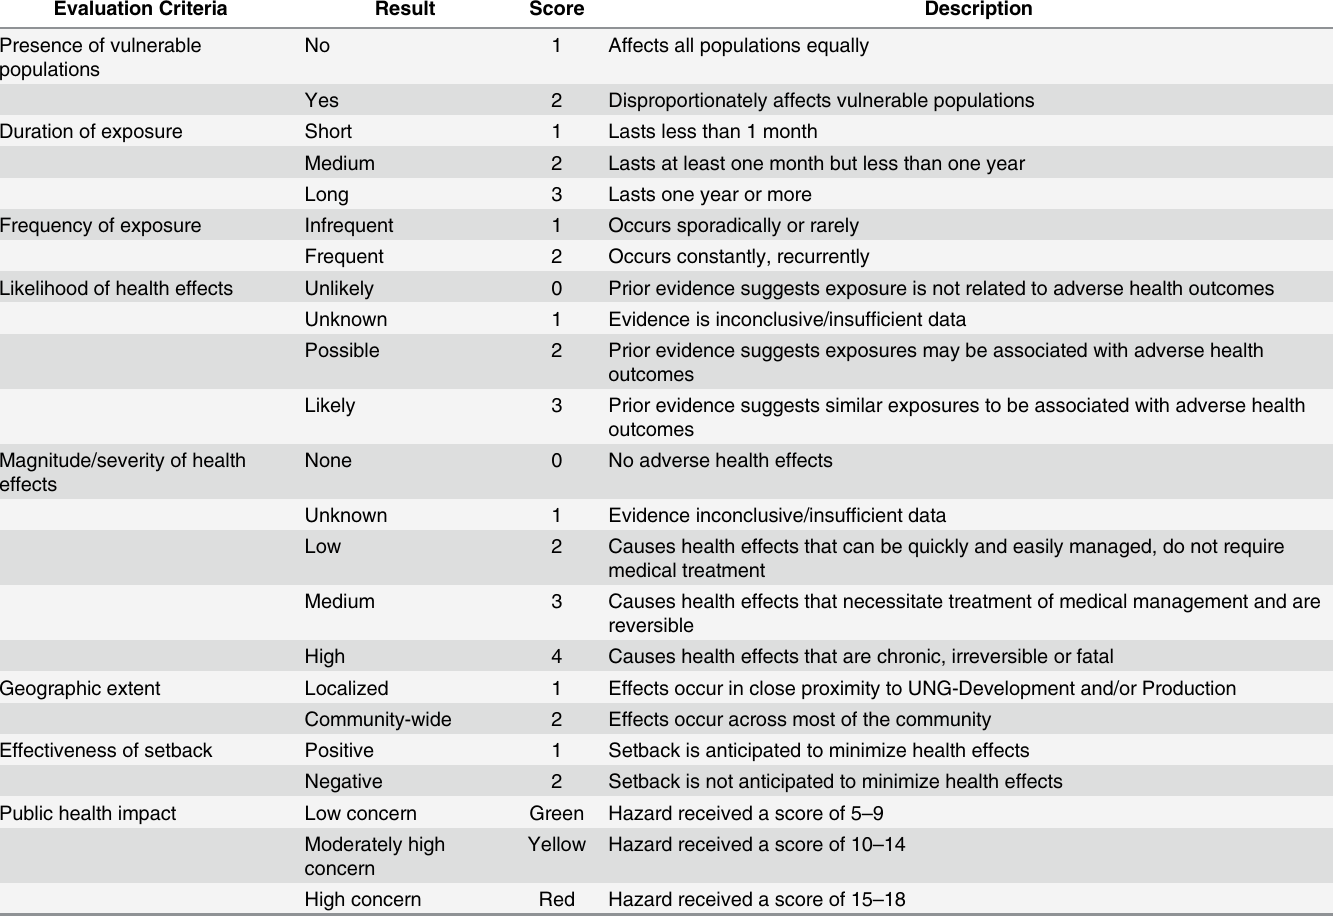
Table 1. Description of the evaluation criteria used for hazard